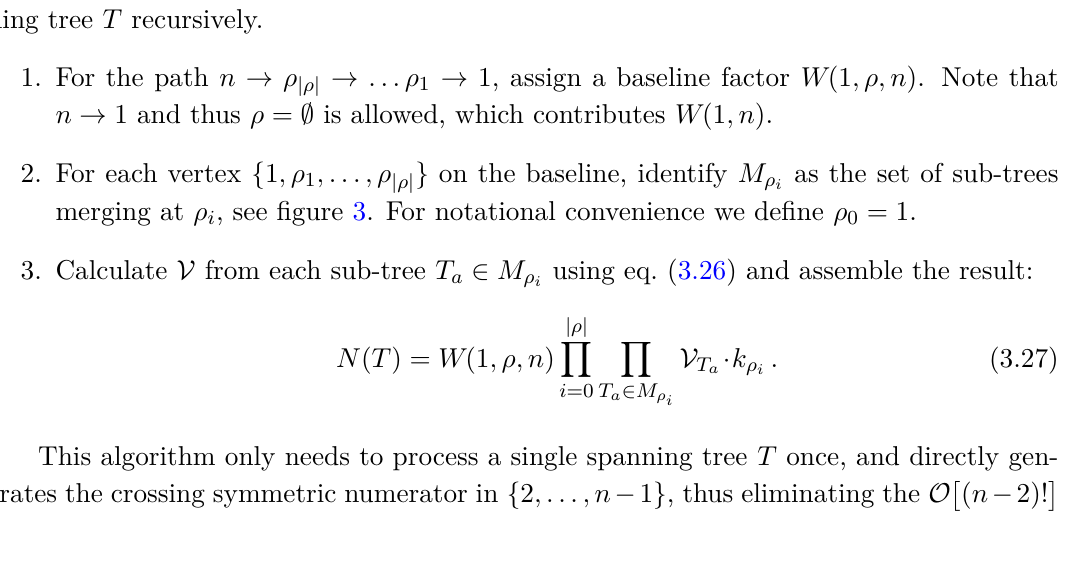
Algorithm 2 (Recursive Evaluation). Construction of the kinematic factor for a span- ning tree T